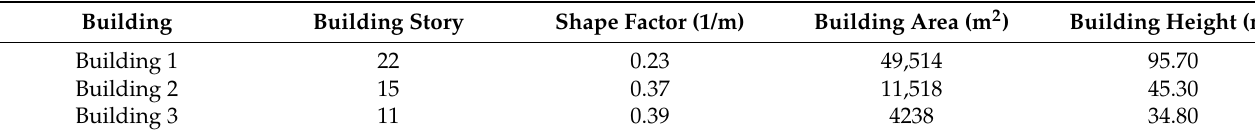
Table 1. Details of the three buildings.